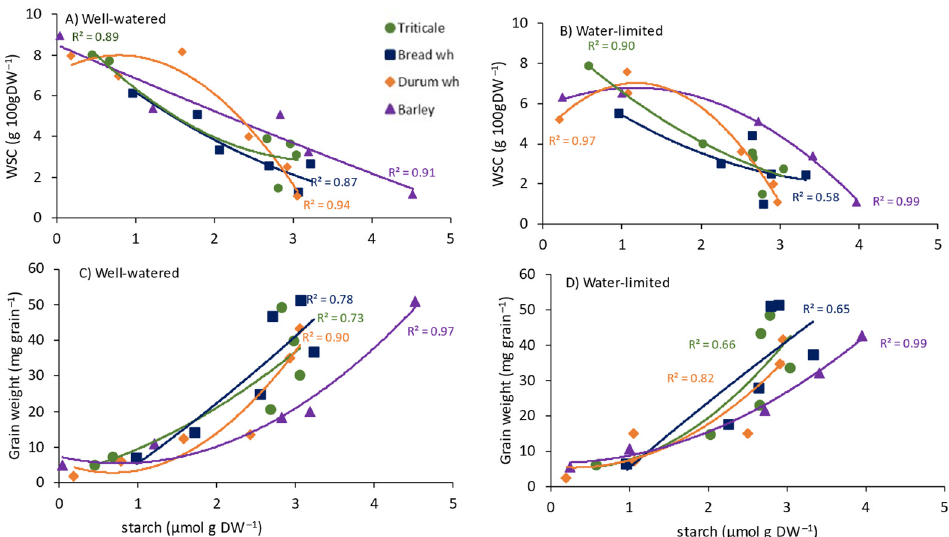
Figure 4. Relationships between starch in grain and water-soluble carbohydrate (WSC) concentrations in grain ( A , B ) and grain weight ( C , D ) of four cereals (triticale, bread wheat, durum wheat and barley) grown under well-watered ( A , C ) and water-limited ( B , D ) regimes. The regression equations are in Table S4.